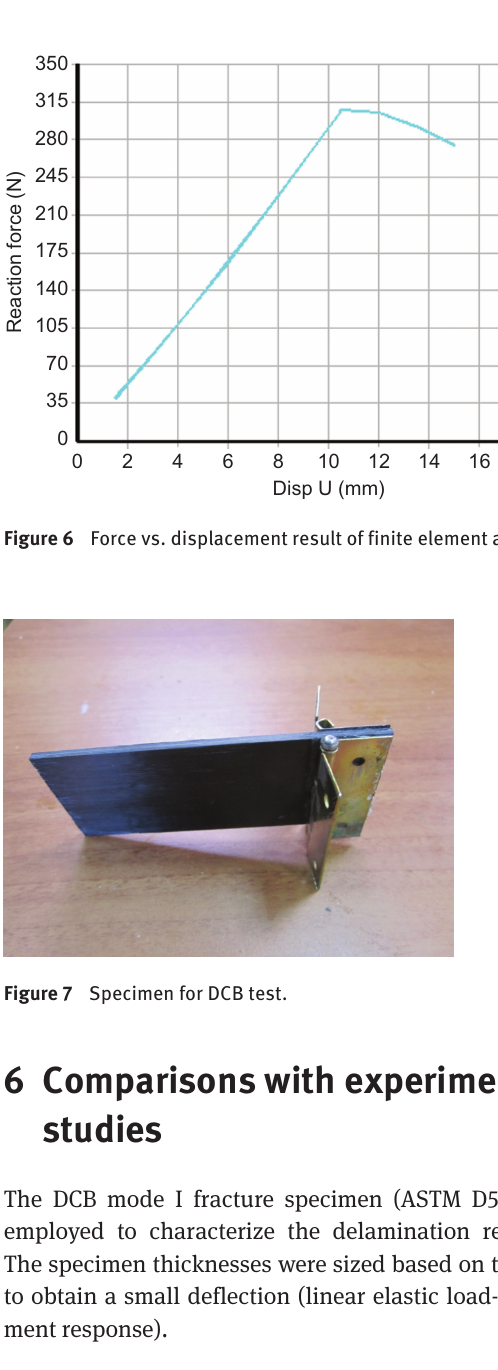
Figure 10 Load-displacement curve for the [0] laminate in the DCB